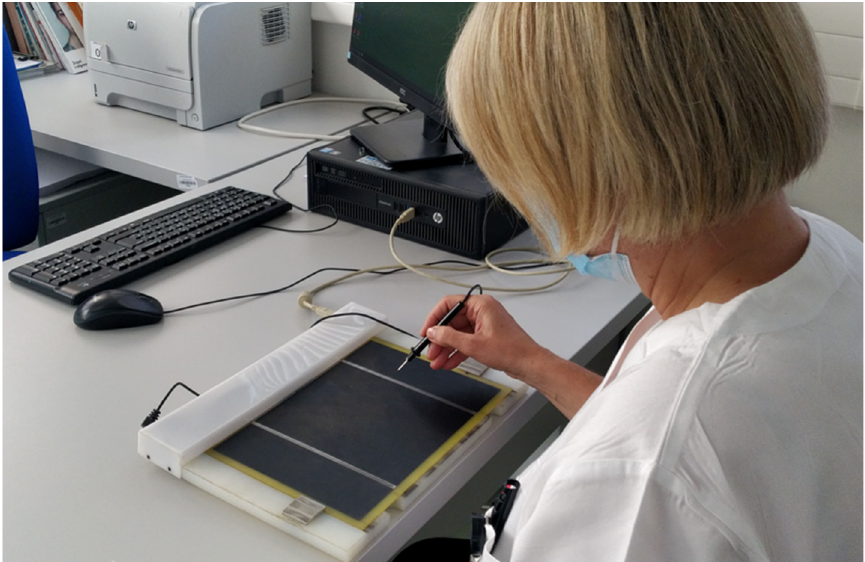
Figure 1. Example of Fitts’ Tapping Task applied in a real-world setting. Legend: The subject is instructed to alternate and touch the strip-targets using the stylus. Trials included different difficulties based on the target widths of 0.5 cm, 1.0 cm, 2.0 cm, and 4.0 cm, and movement amplitudes of 4.0 cm, 8.0 cm, 16.0 cm, respectively.